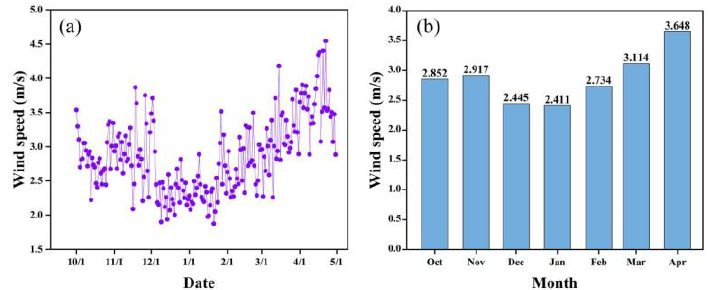
Figure 10 . The seasonal changes of average wind speed of the Chagan lake during the recent eight cold season from October 2013 to 2015: ( a ) the time series of daily wind speed; ( b ) the bar chart of monthly mean values.